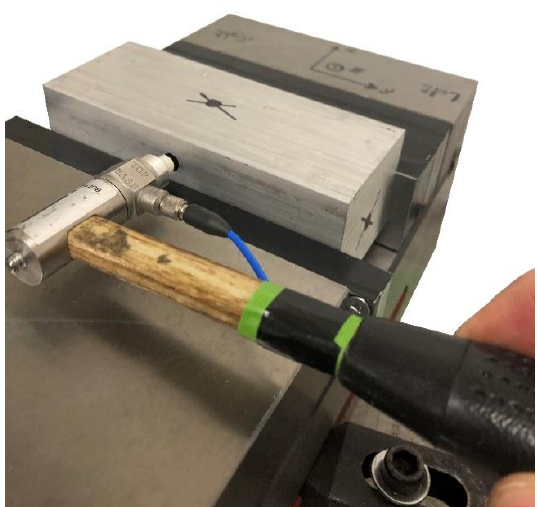
Figure 14. Impact hammer test to find the FRFs.